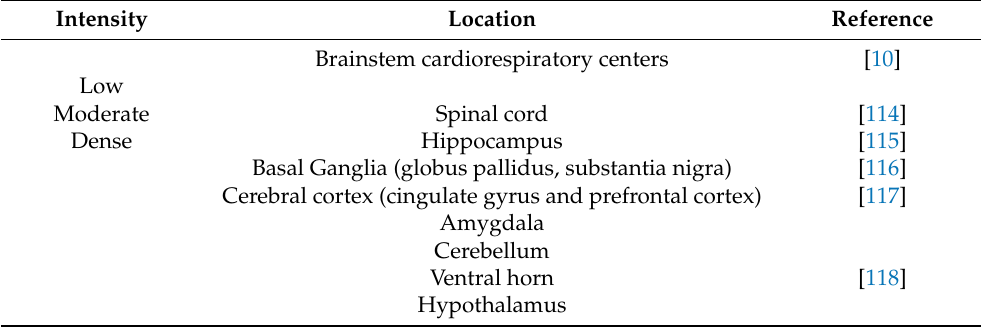
Table 1. The location and intensity of CB1 receptors in the human